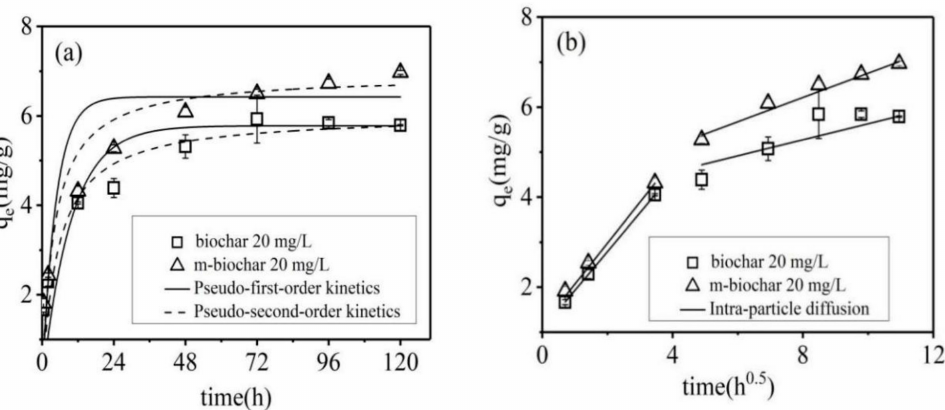
Figure 3. The kinetics of Cr(VI) adsorption on the pristine biochar and m-biochar and the simulated pseudo-first-order kinetics and pseudo-second-order kinetics models ( a ) and the intra-particle diffusion model ( b